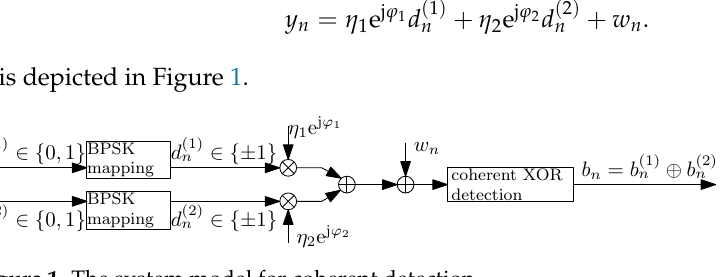
Figure 1. The system model for coherent detection.